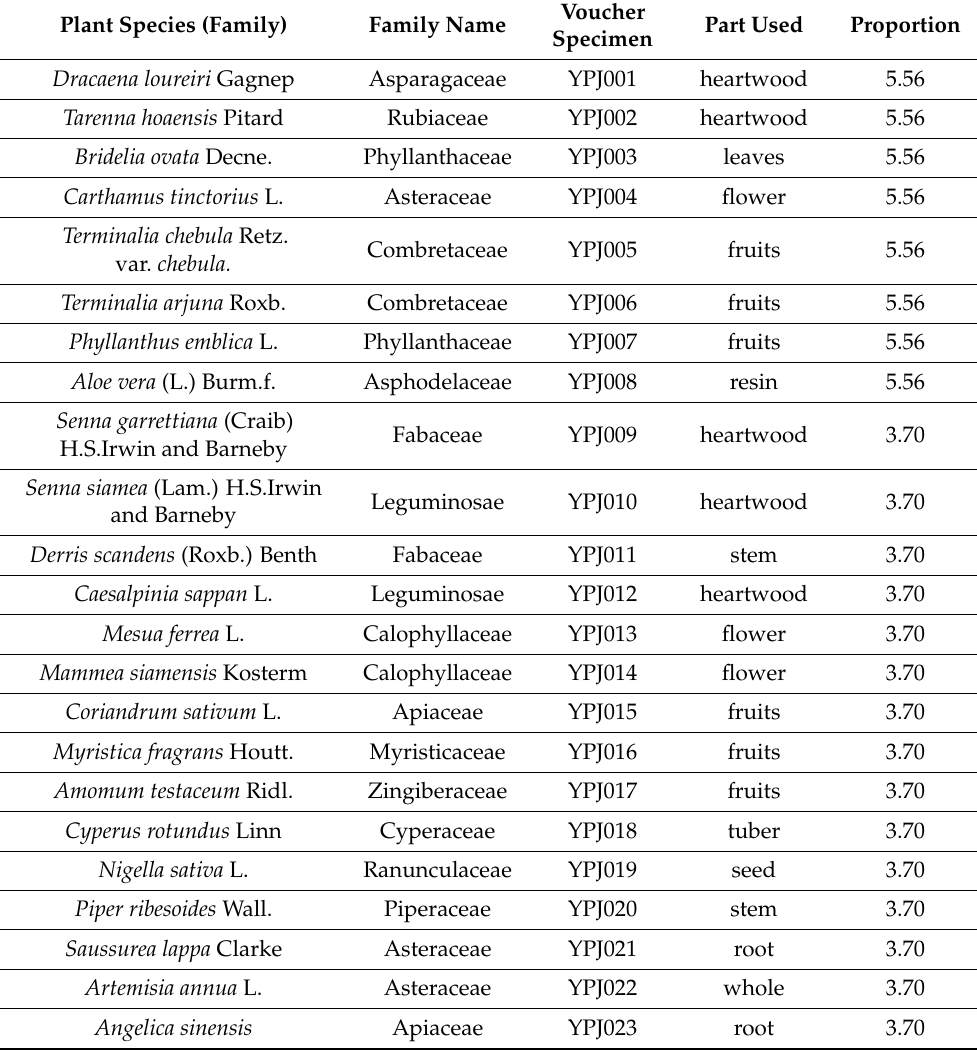
Table 1. List of medicinal plants in YPJ remedy, part used, and